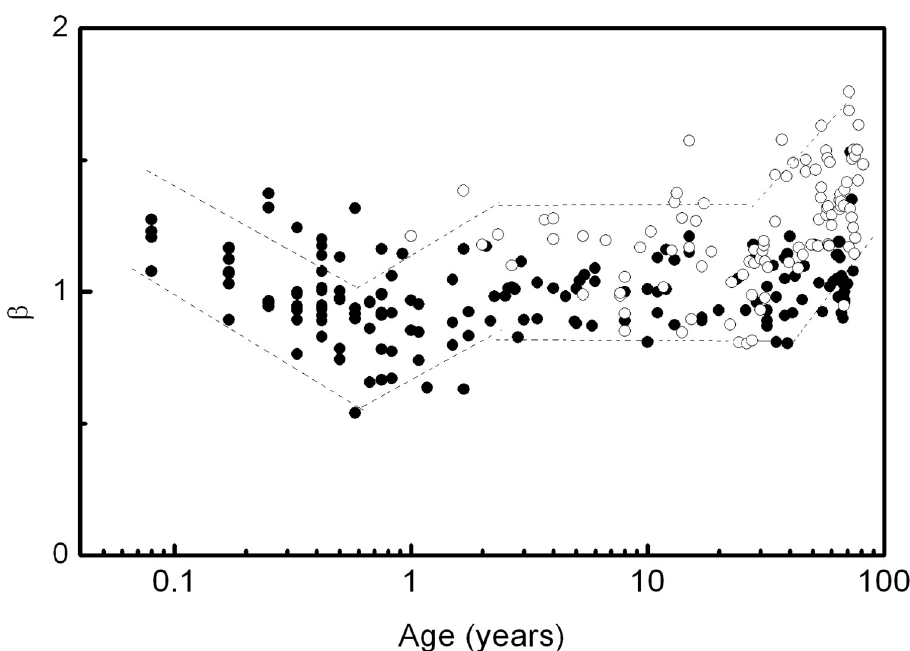
Fig 2. β dependence on age. Filled circles correspond to data obtained in this work, open circles to data from [34]. Dashed lines indicate the approximate 95% prediction interval (see Procedure).